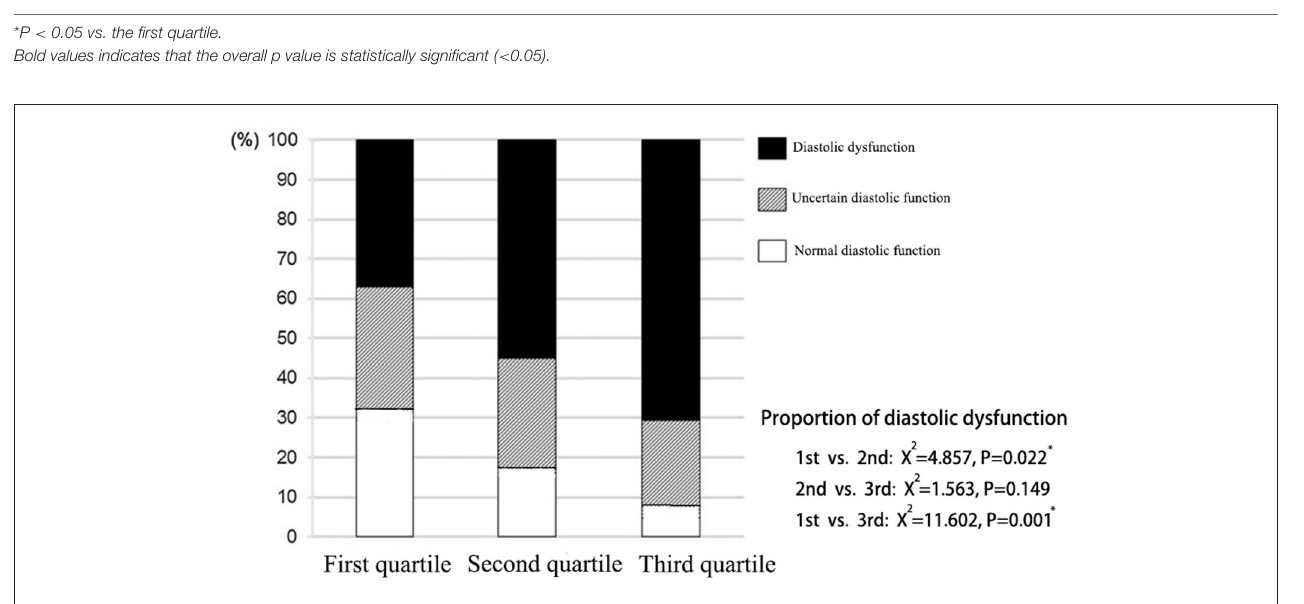
FIGURE 3 | Distribution of left ventricular diastolic function in patients with different liver hardness groups.